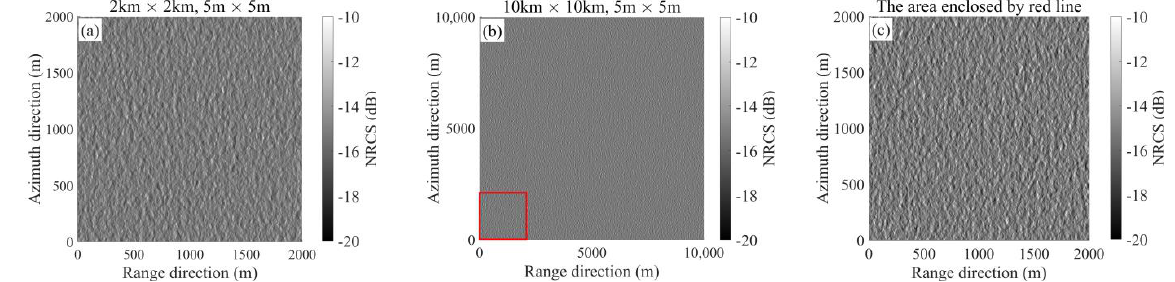
Figure 24. Comparison of scattering images based on different ocean surface sizes at the incidence angle of 40° and wind speed of 10 m/s in the upwind direction under VV polarization. The facet resolution is 5 m × 5 m. ( a ) Sea surface in the area of 2 km × 2 km; ( b ) sea surface in the area of 10 km × 10 km; ( c ) the area enclosed by red solid line in ( b ).